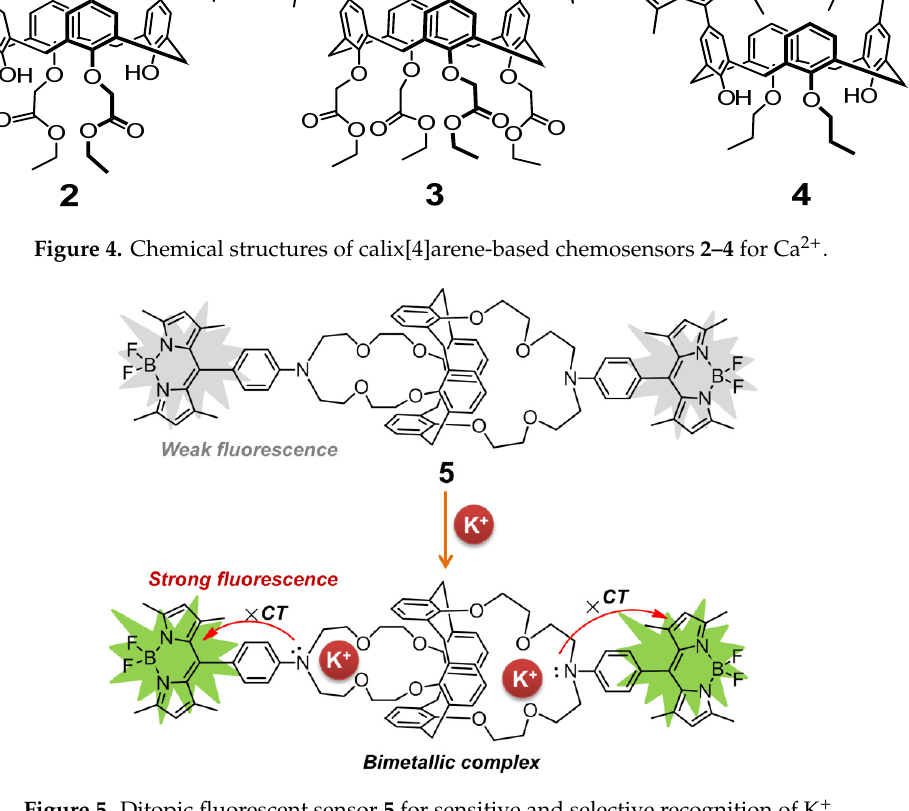
Figure 5. Ditopic fluorescent sensor 5 for sensitive and selective recognition of K + .